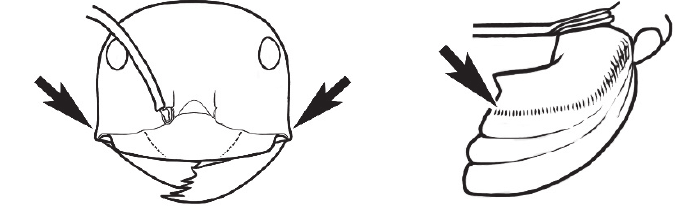
at midpoint of clypeal sclerite, then masticatory margin of mandible oblique and basal tooth distinctly offset and may be enlarged; anterior clypeal margin generally planar or nearly so in full-face view ............................................ 98 98 In full-face view, broad head capsule of minor worker expanded towards mandibular insertions giving it a slight to strongly accentuated trapezoidal shape; basal margin of known major worker mandible a carinate ledge set at 90° to the rest of the mandible throughout its length, the (slightly) offset basal tooth horizontal and the sub-basal tooth with a horizontal and a verti- cal plane; mandibular carina present to varying degrees in media and minor workers; workers with glabrous mesosoma ................................................